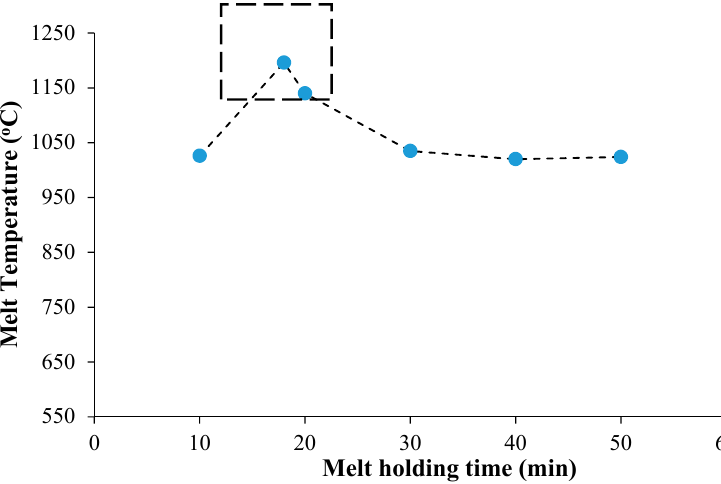
Figure 1. Temperature variation due to exothermicity of reactions during liquid metal processing in induction furnace.